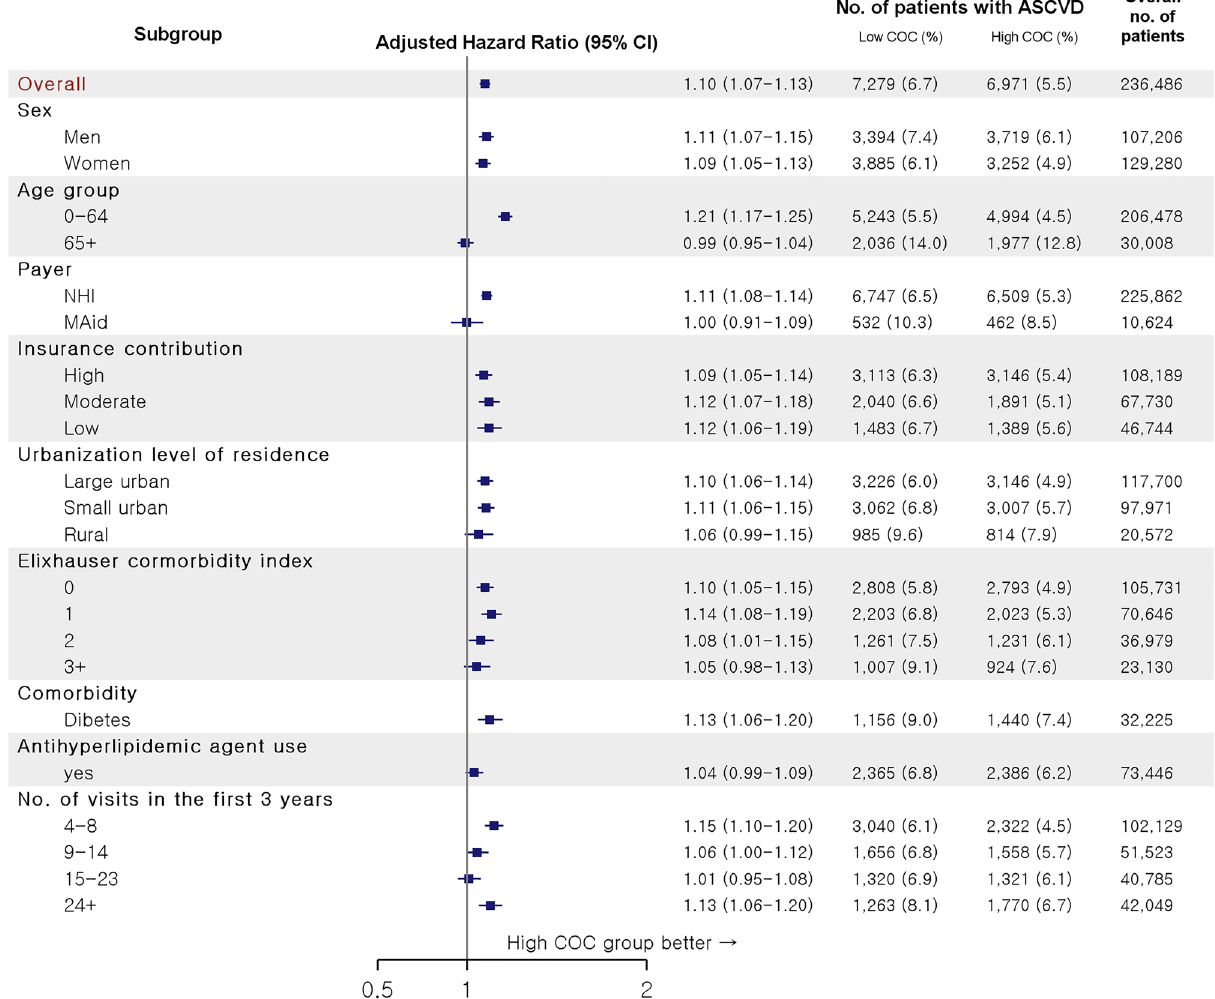
Figure 5. Subgroup analysis for the association between continuity of care and the risk for the four ASCVDs. ASCVD atherosclerotic cardiovascular disease, CI confidence interval, COC continuity of care, MAid Medical Aid, NHI National Health